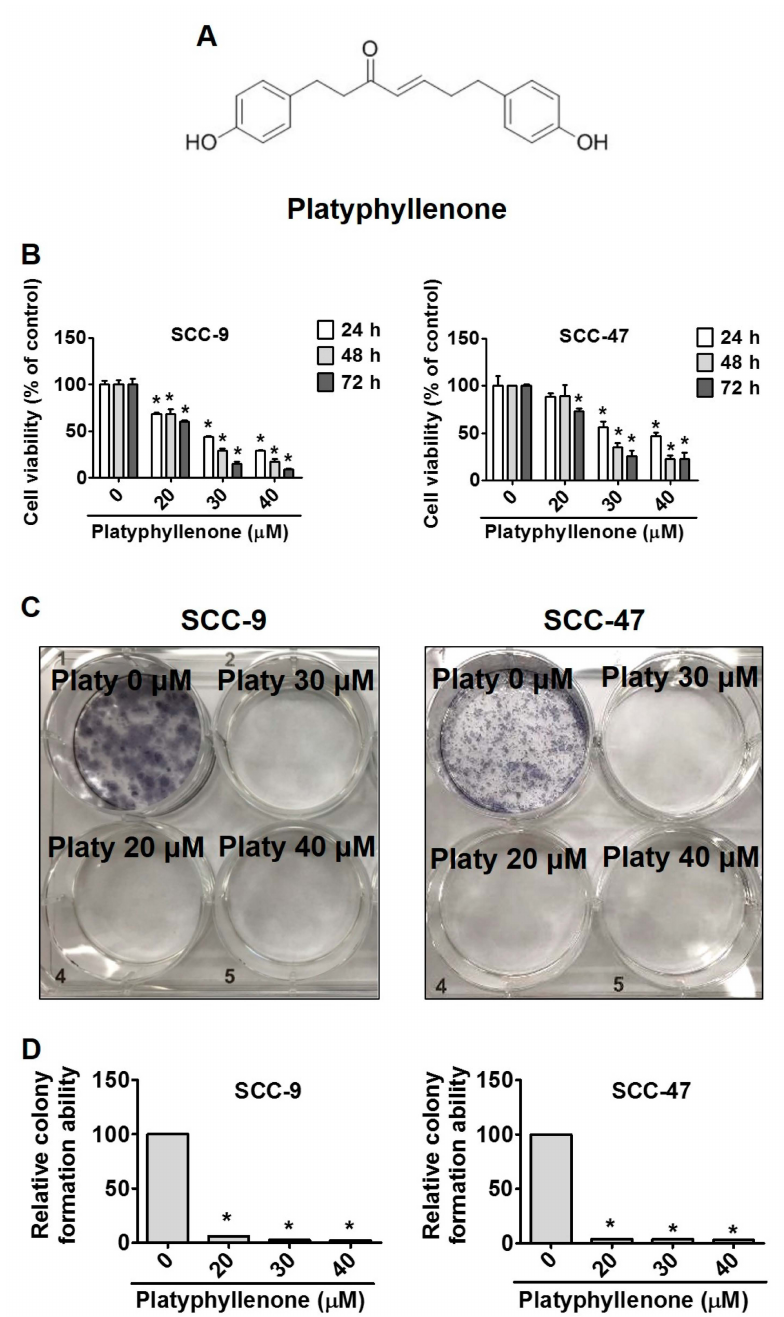
Figure 1. Platyphyllenone induces cytotoxicity and inhibits colony formation in oral cancer cell lines. ( A ) Chemical structure of platyphyllenone. ( B ) SCC-9 and SCC-47 cell lines were treated with different concentrations (0, 20, 30 and 40 µ M) of platyphyllenone for 24 h, and the cell viability was determined by MTT assay. The values represent the means ± SD of at least three independent experiments. ( C ) After treatment with platyphyllenone, SCC-9 and SCC-47 were confirmed by colony formation assay. ( D ) Quantitative analysis of colony formation of SCC-9 and SCC-47 cells. Student’s t test was applied to determine statistical significance, and two-tailed p values are shown (* represents p <